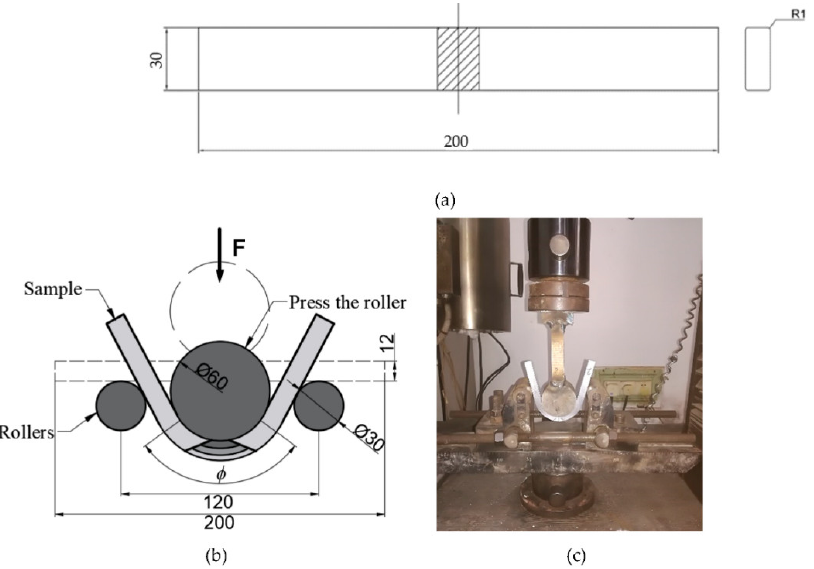
Figure 3. ( a ) Sample size of bent specimen, ( b ) face bend sample size and schematic diagram, and ( c ) face bend test set-up.